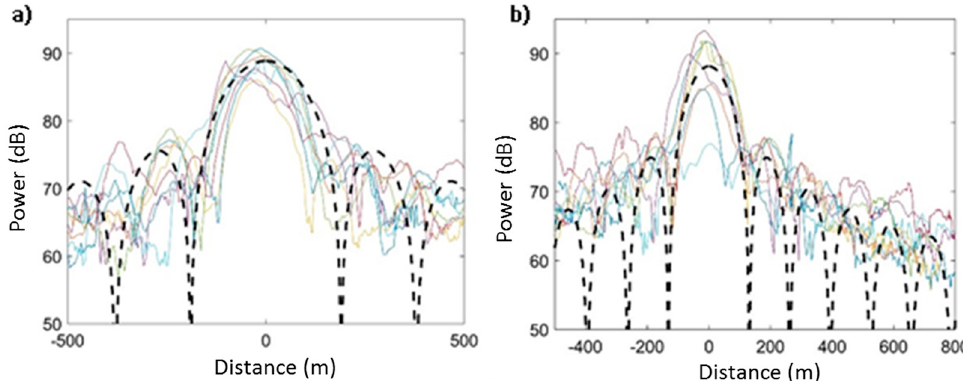
Figure 12. ( a ) RCSs and model RCS for Crossing 2, 45-m wide; ( b ) RCSs and model RCS for Crossing 3, 65-m wide.